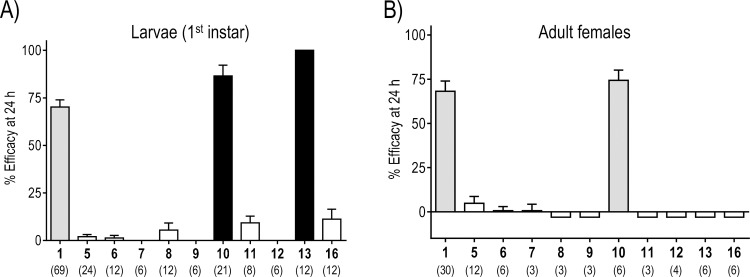
Toxic efficacy of cinnamodial and derivatives against larval (A) and adult female (B) Ae. aegypti. The efficacy values were calculated using Abbott’s correction to account for control (100% acetone) mortality [26]. In A), compounds were added to the rearing water of 1st instar larvae (100 μM) and efficacy was defined as the percentage of larvae that died within 24 h. In B), compounds were applied to the thoracic cuticle of adult females (1.5 nmol/mosquito) and efficacy was defined as the percentage of adults that were incapacitated (dead or flightless) within 24 h. Values are means ± SEM based on at least 6 replicates of 5 larvae each or 3 replicates of 10 adult females each. The specific numbers of replicates for each are indicated in parentheses below the compound number. Shading indicates statistical categorization of a derivative’s efficacy relative to CDIAL as determined by a one-way ANOVA with a Bonferroni post-test: gray = similar (P > 0.05); filled = superior (P < 0.05); open = inferior (P < 0.05).